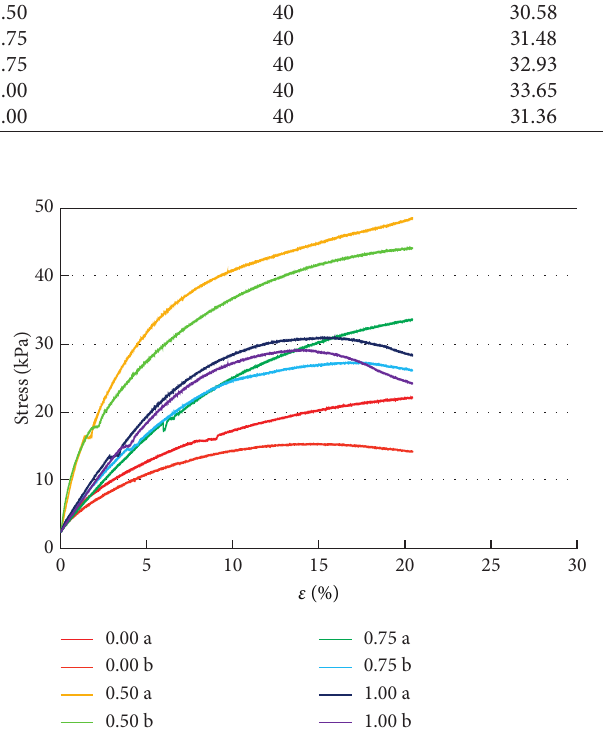
Figure 9: Stress-strain curves from the unconfined compression tests run on the soft clay specimens cured in the moisture cylinder for 28